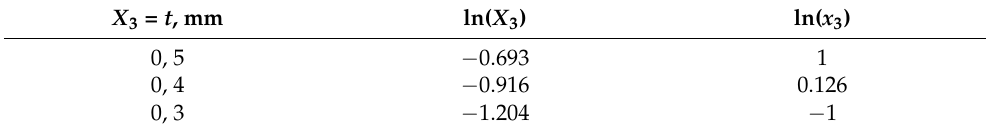
Table 4. Encoded values of cutting depth t .